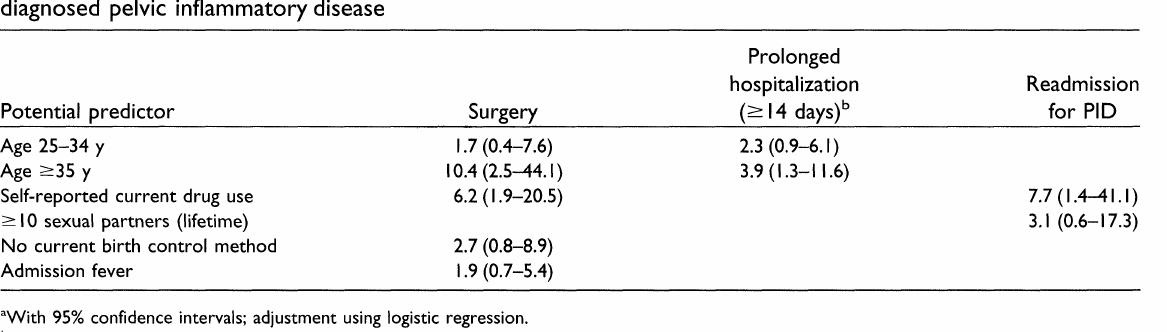
C. trachomatis culture